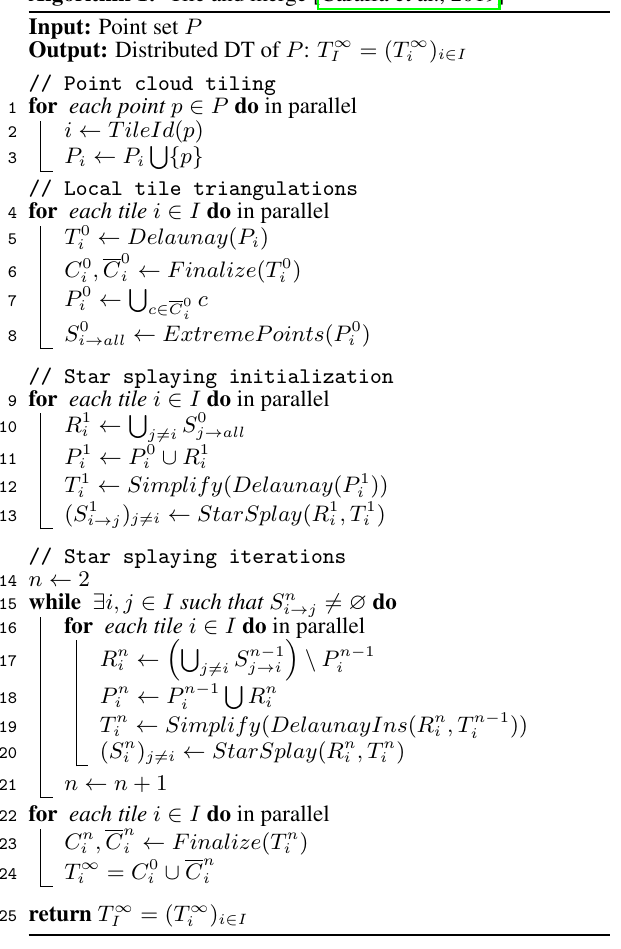
Algorithm 1: Tile and merge [Caraffa et al.,